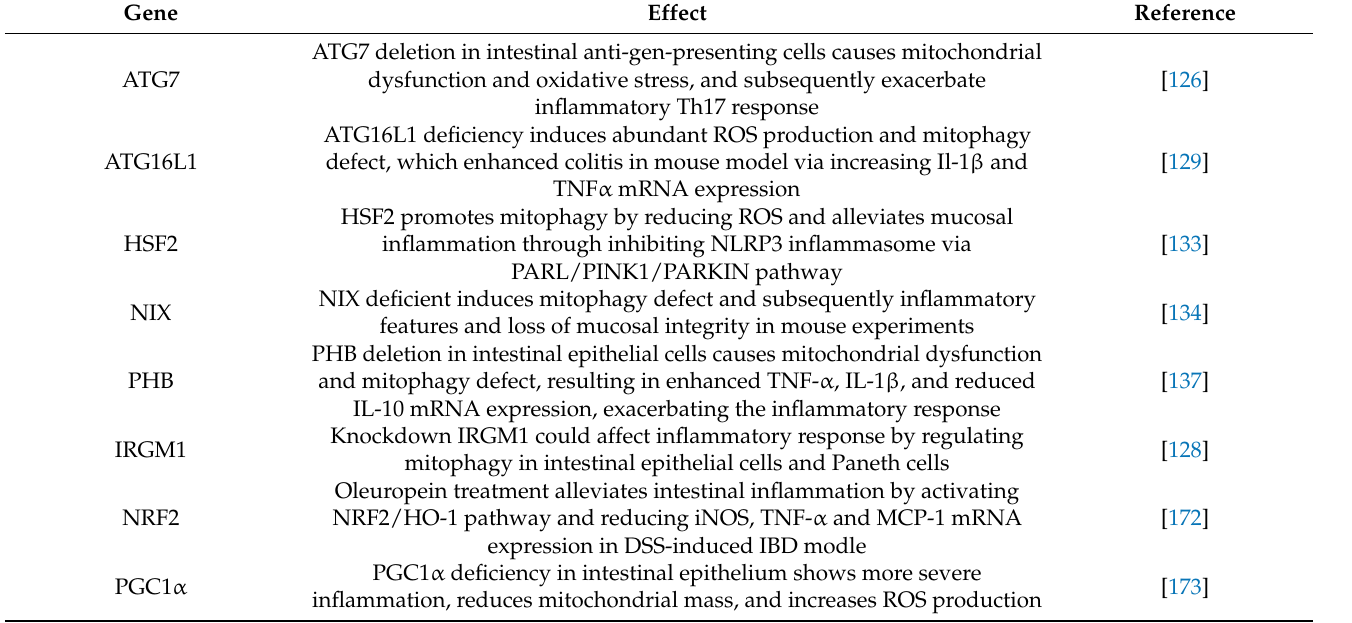
Table 1. The role of mitochondrial homeostasis related proteins in